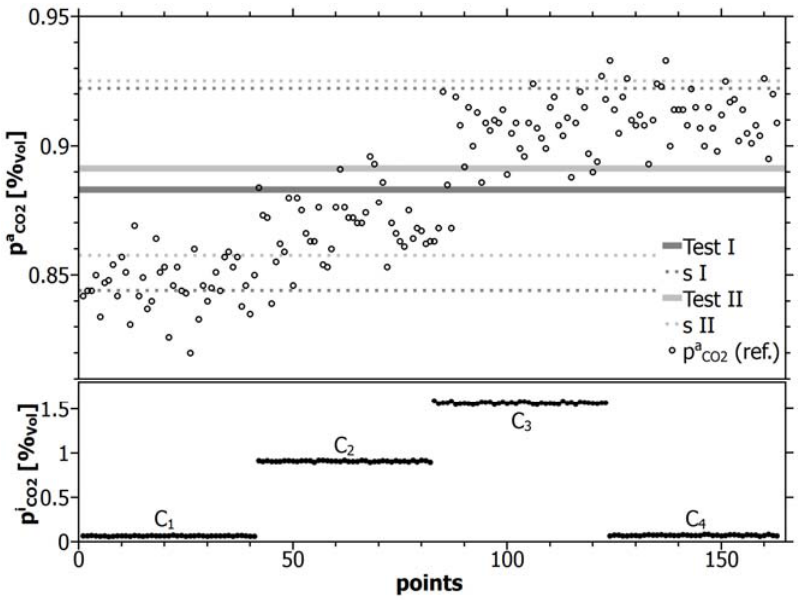
Figure 9. Upper diagram: background concentration within the vessel (circles) observed directly by the reference and determined during the course of inverse calibration tests (lines) for line-sensor 1. The dark line represents Test I and the light line Test II. Dotted lines show the standard deviations. The lower diagram shows the respective CO –C ) of the reference gas for inverse calibration. concentrations (C 1 4